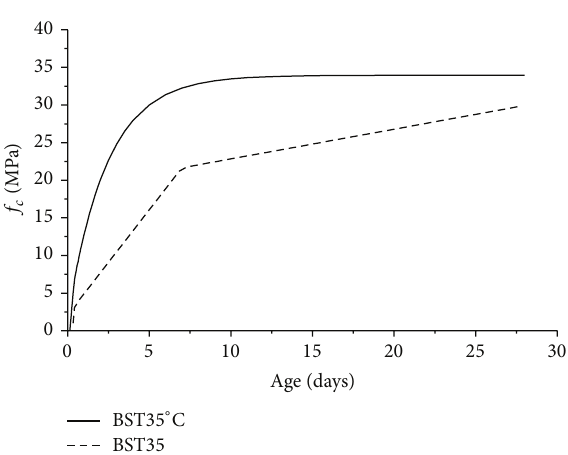
Figure 6: Simulated and experimental strength development curves of heat treated ordinary concrete at 35 ∘ C.